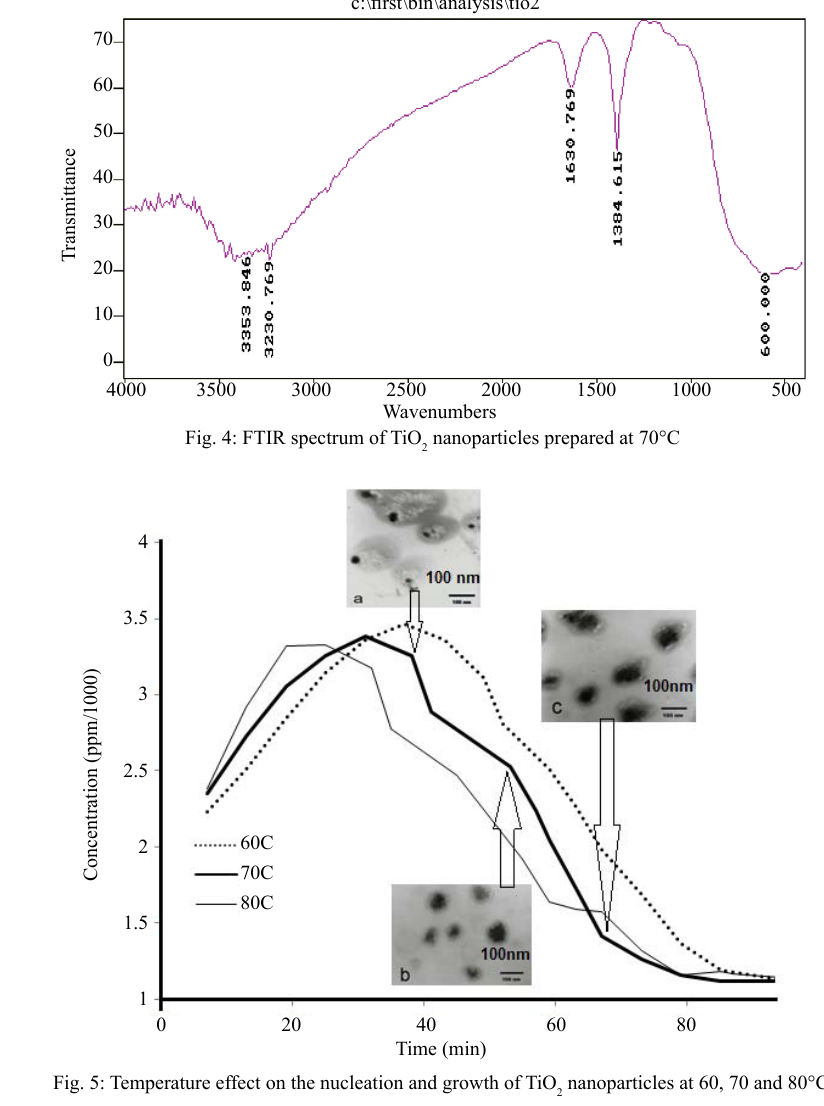
nanoparticles at 60, 70 and 2